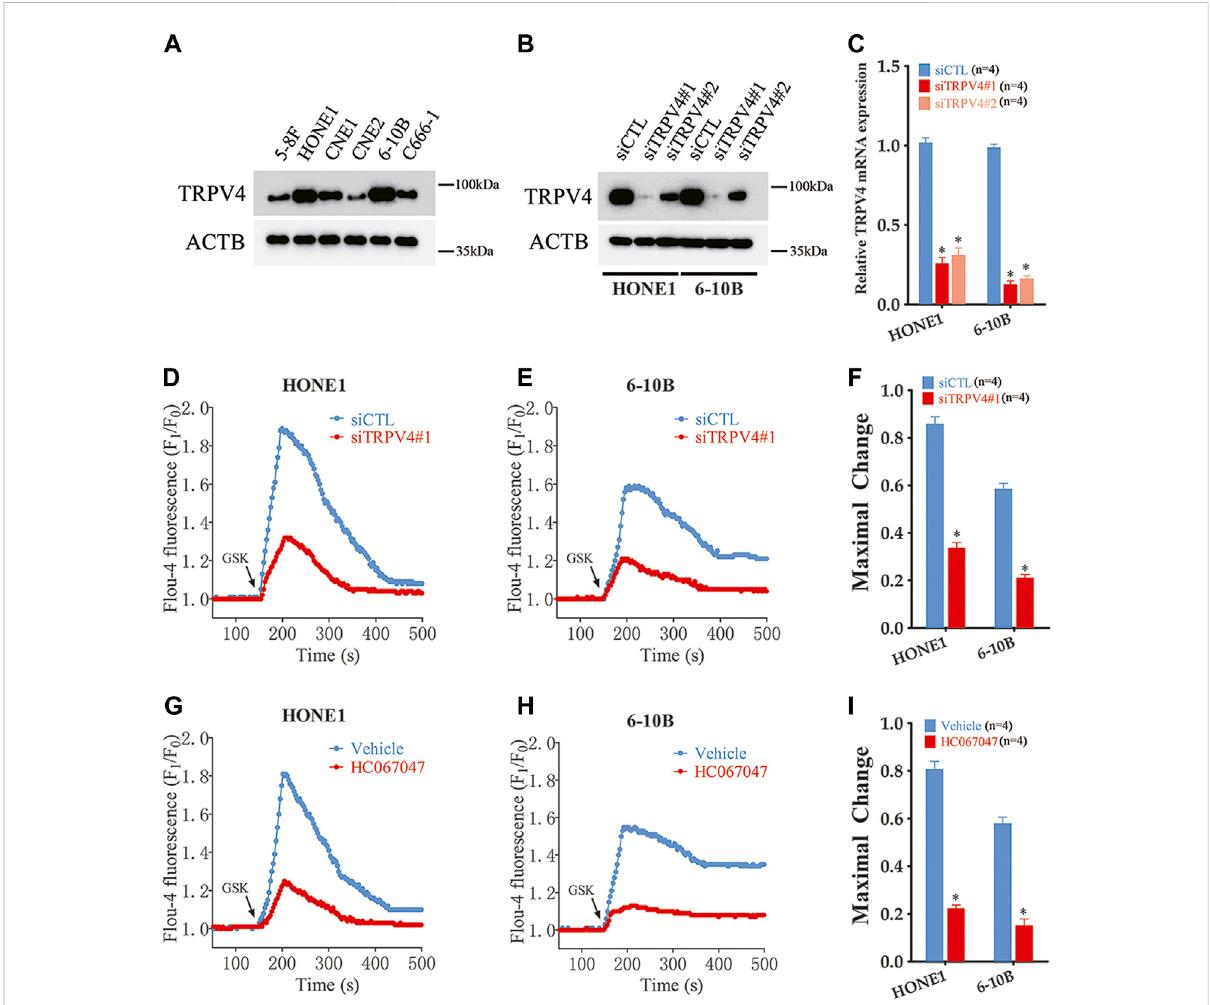
FIGURE 2 TRPV4 is functional expressed in NPC cells (A) Immunoblot showing TRPV4 expression in NPC cells (n = 4). (B,C) TRPV4 protein and mRNA expression in NPC cells transfected with control siRNA (siCTL) or TRPV4 siRNA (siTRPV4#1 and siTRPV4#2) (n = 4). (D,E) Representative single measurement for levels of intracellular Ca 2+ in response to GSK1016790A (GSK, 100 nM) in NPC cells transfected with siCTL or siTRPV4#1. Fluo-4 fl uorescence was excited at 488 nm and the signals relative to the starting signal (F1/F0) were calculated to quantify the cytosolic Ca 2+ change. (F) Summary data of maximal change for D and E (n = 5). (G,H) Representative single measurement for levels of intracellular Ca 2+ in response to GSK (100 nM)inNPC cells pre-treatedwith vehicle(0.1% DMSO)orHC067047 (4 μ M)as inDandE. (I) Summary data ofmaximal change forG andH(n = 5). The data is the mean ± SEM. * p < 0.05, versus vehicle or